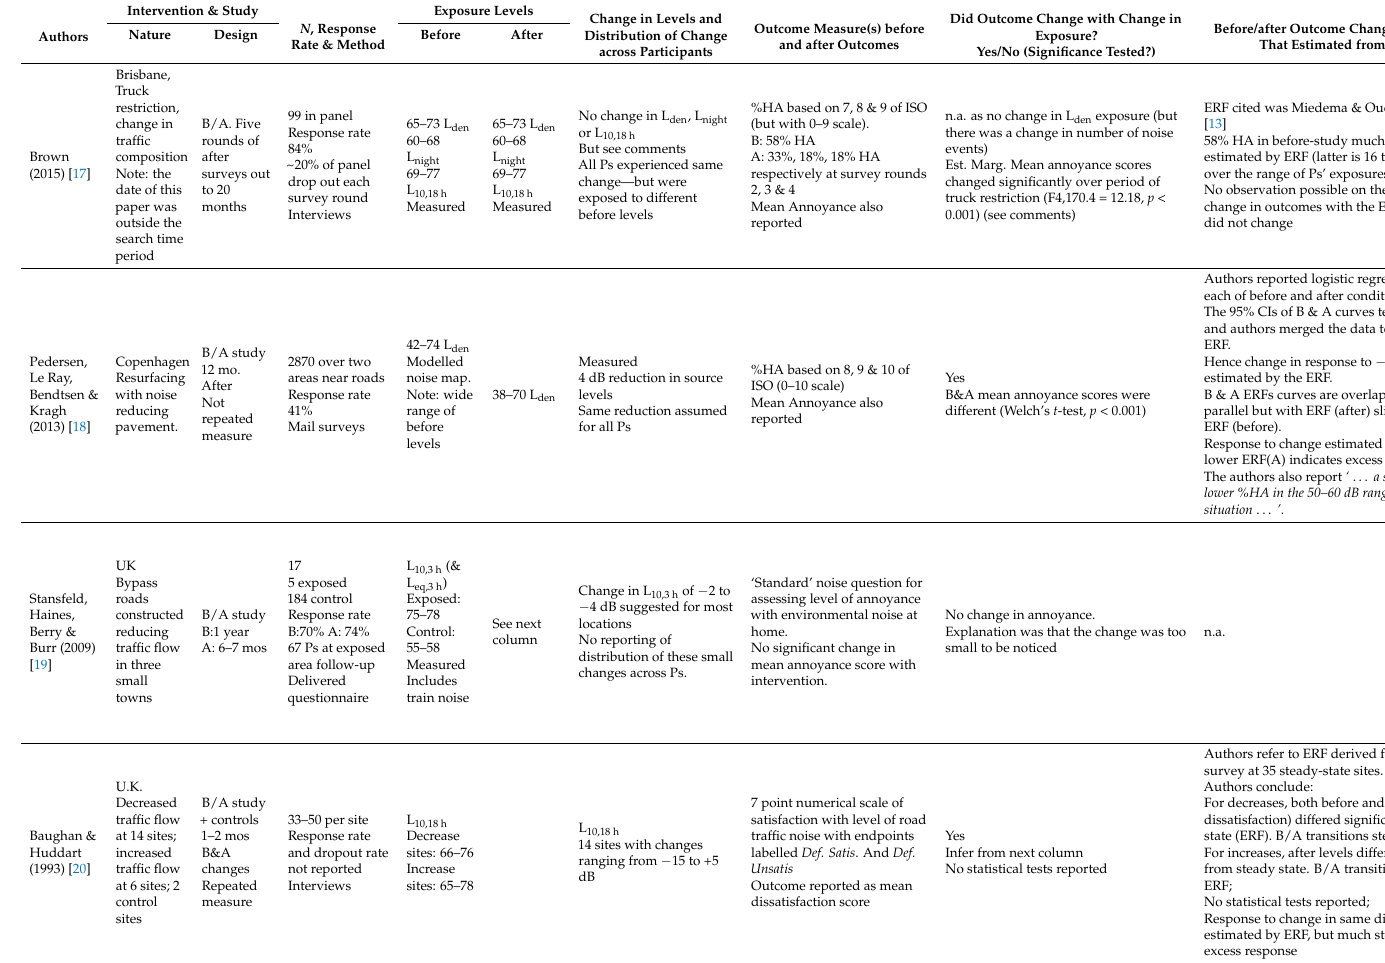
Table 3. Source Interventions (Type